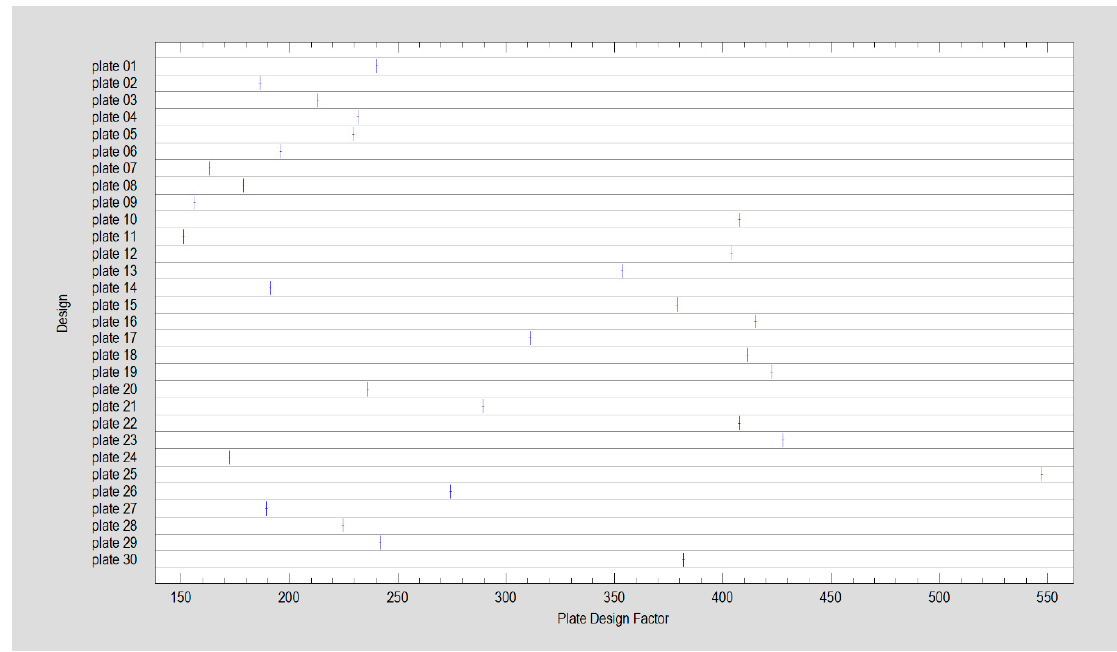
Figure 5. Calculated feature: Plate Design Factor, numerically describes each plate design.